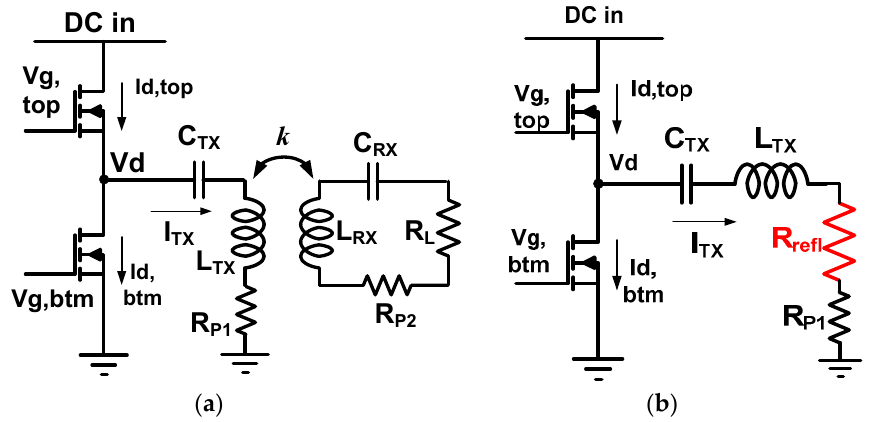
Figure 1. ( a ) Circuit model of a resonant wireless power transfer system. ( b ) From the viewpoint of the transmitter. The coupling with Rx is abstracted as reflected resistance, which serves as the load resistor of a Class-D inverter.